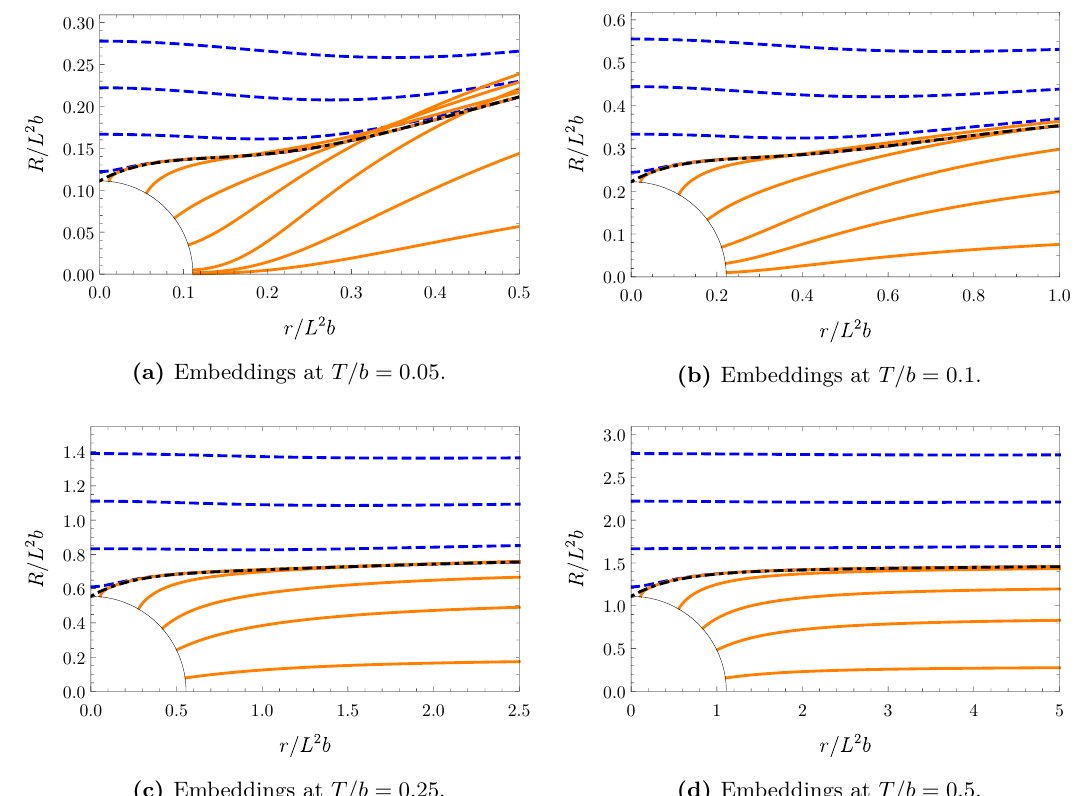
Figure 2. Examples of our numerical solutions for R ( r ) / ( L 2 b ) as functions of r/ ( L 2 b ) when T/b > 0 . In each plot, the solid black quarter-circle is the horizon ρ H , given by ρ 2 The dashed blue, solid orange, and dot-dashed black lines are Minkowski, black hole, and the critical embeddings, respectively, for (a) T/b = 0 . 05 , (b) T/b = 0 . 1 , (c) T/b = 0 . 25 , and (d) T/b = 0 . 5